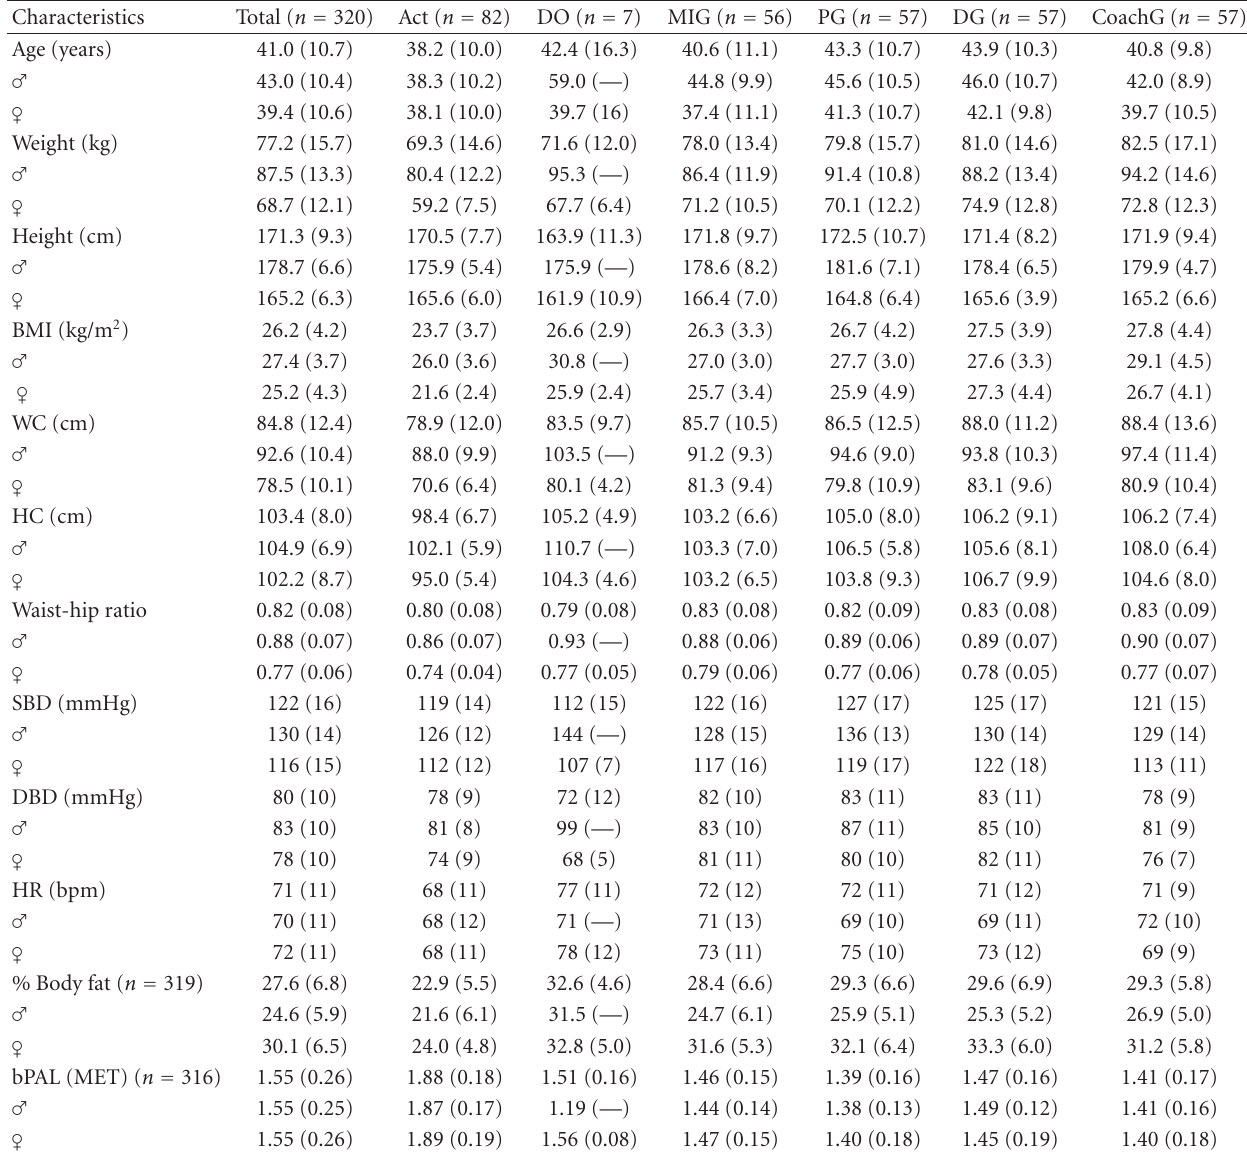
Table 1: Baseline